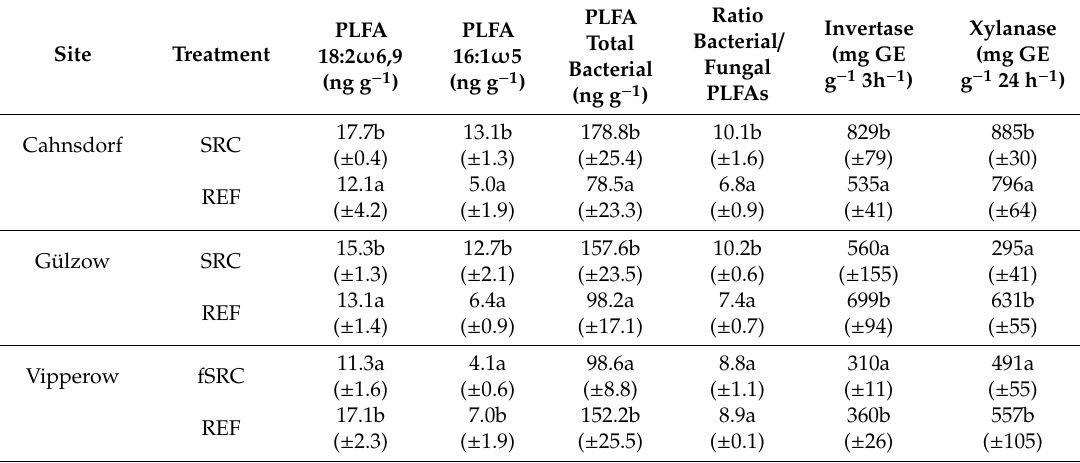
Table 3. PLFA contents, ratio of bacterial to fungal PLFAs, invertase and xylanase activities of the